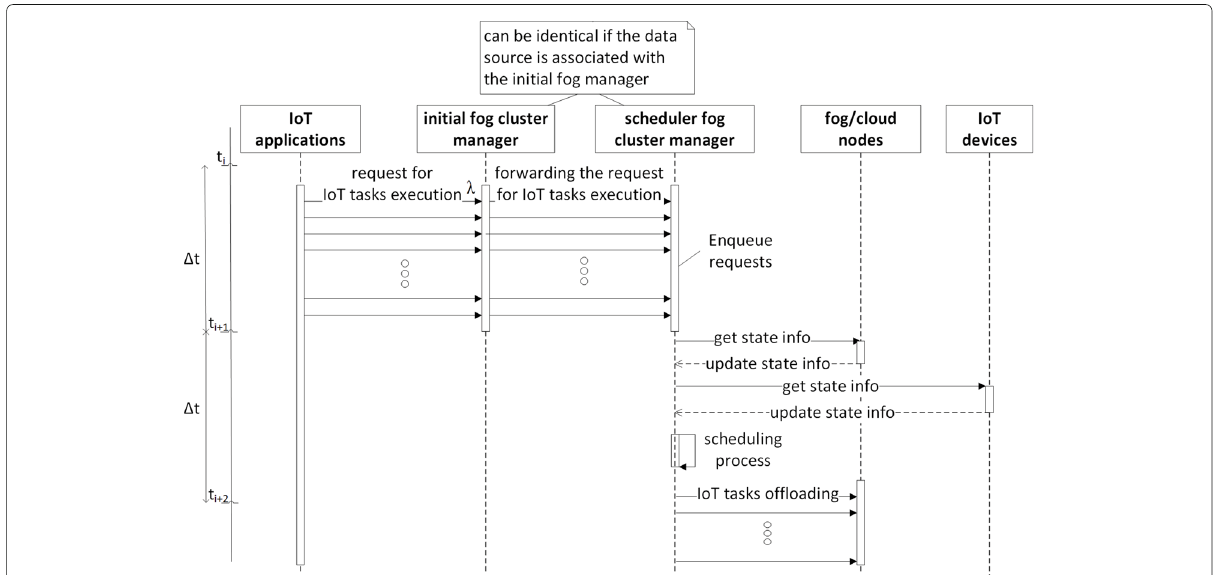
Fig. 2 The process of handling the IoT task requests for task scheduling